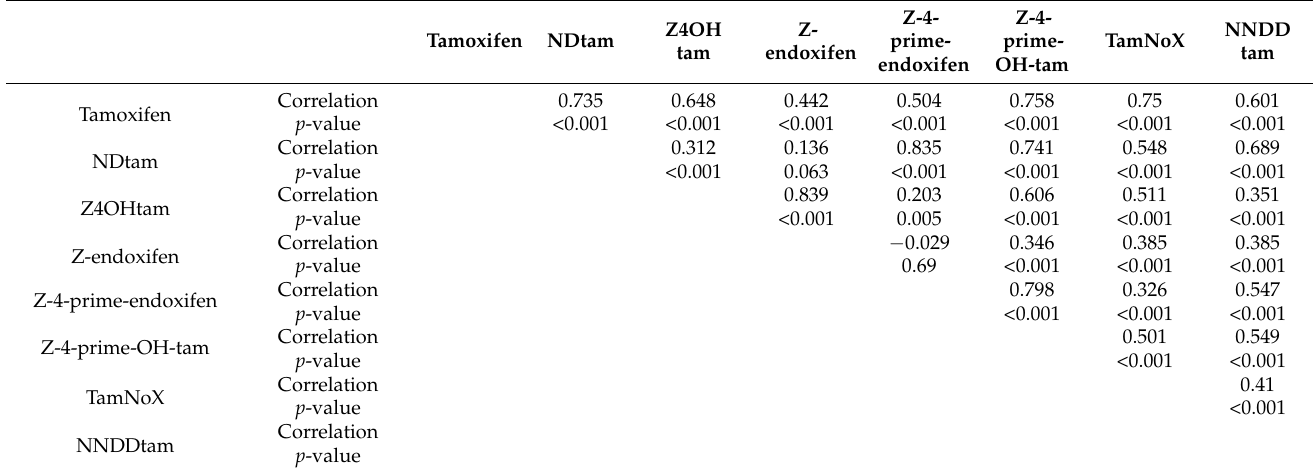
Table 3. Pearson Correlation Between Tamoxifen Metabolites.